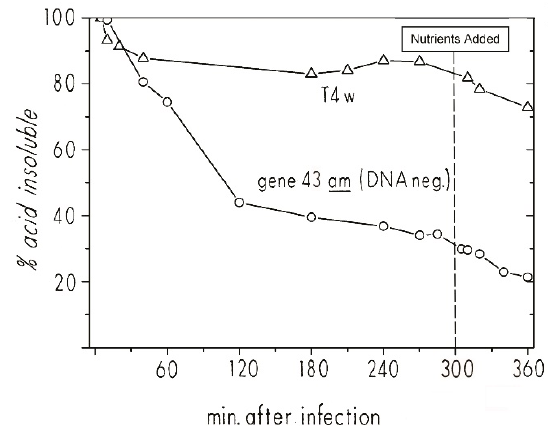
Figure 7. The breakdown and reutilization of host DNA and 3 HdT DNA label reincorporation in stationary phase after T4 and T4 4332 amber DNA polymerase mutant infection: Host DNA degradation analysis of ZK126 that was labeled with tritiated thymidine during exponential growth and then infected at 48 h in stationary phase with either T4D or T4 am4332 (DNA polymerase). Figure reproduced from [27].